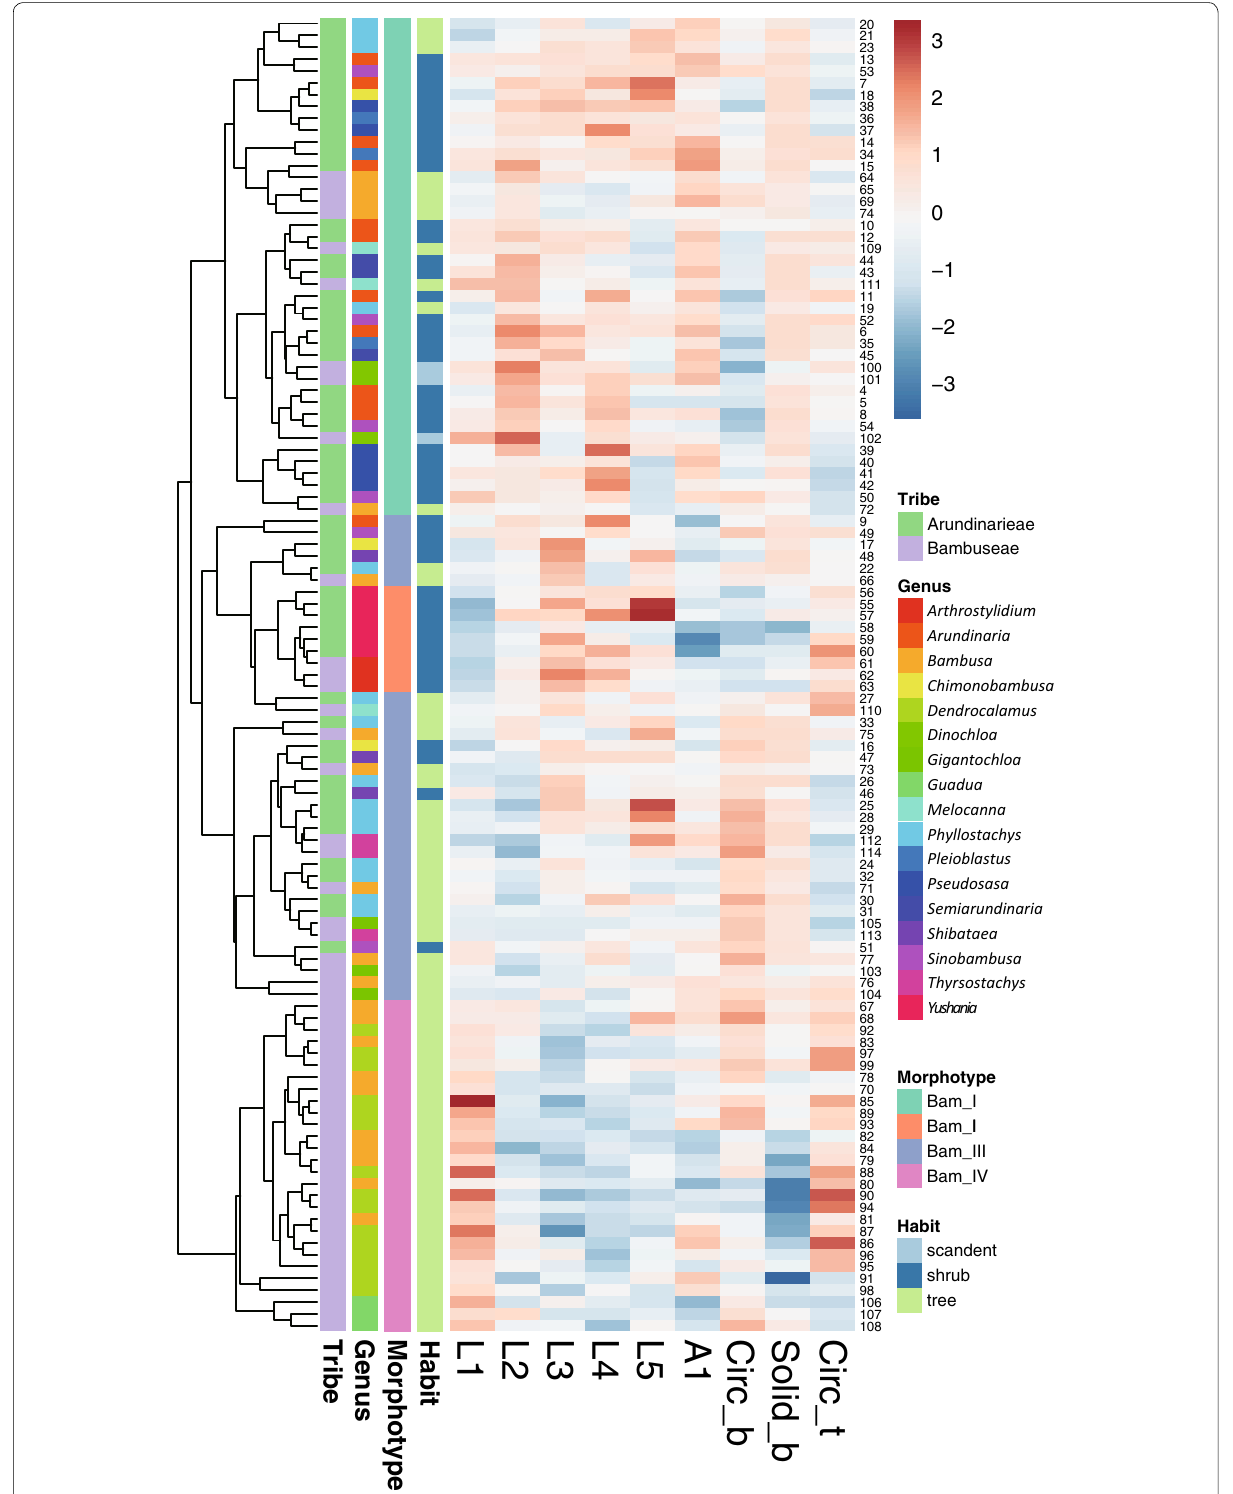
Fig. 7 Cluster diagram and heat map of shape parameters from the analysis including measured samples of subfamily Bambusoideae. The numbers are identical to the sample numbers in Table